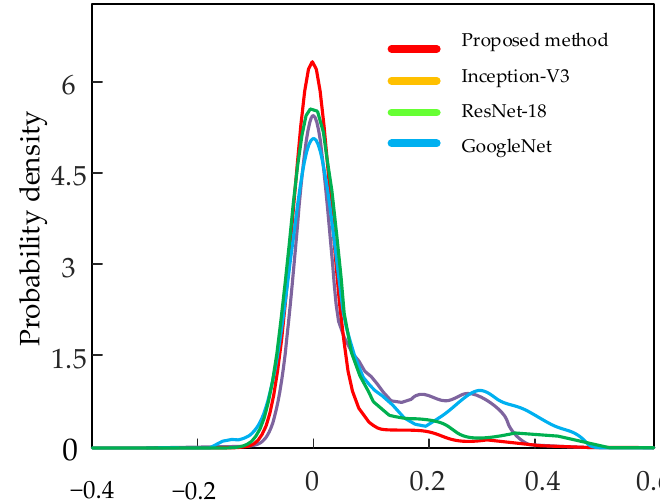
Figure 15. Uncertainty distribution for different methods.